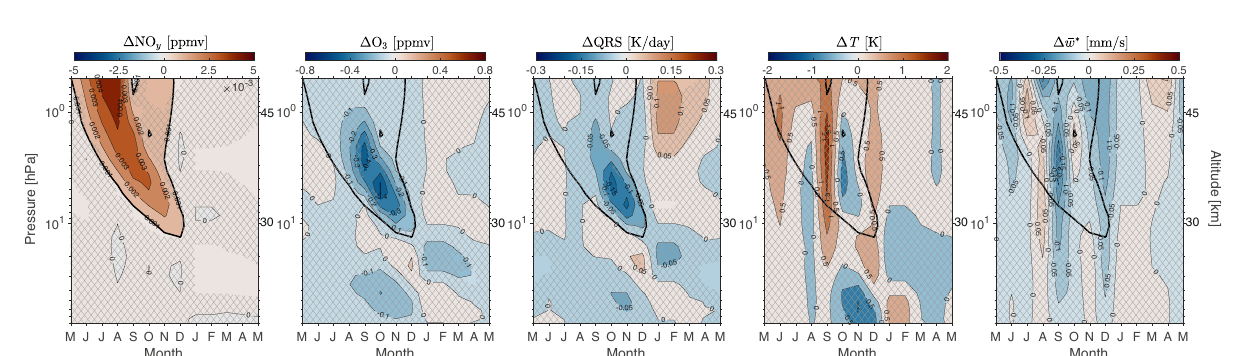
Fig. 3 | Stratospheric response to interannual variations in energetic particle precipitation (EPP). Nitrogen family, NO y (NO x , HNO 3 , N 2 O 5 , ClONO 2 , HNO 4 ), ozone (O 3 ), short-wave heating rate (QRS), temperature ( T ) and vertical residual wind ( w * ) for High EPP-Low EPP years in the SH polar region (60 – 90°S). Hatching indicatesareasnotstatisticallysigni fi cantat95%levelbasedonthe t test( p >0.05).